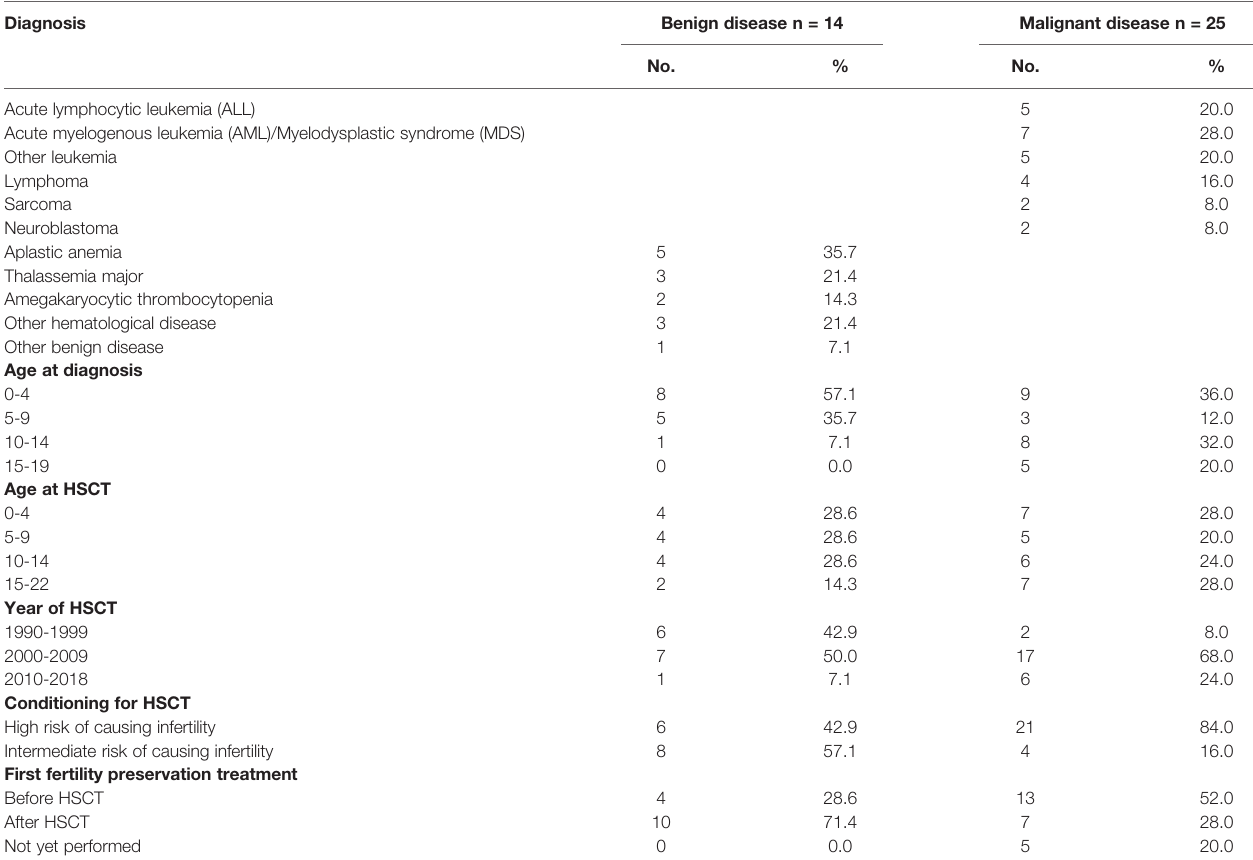
TABLE 1 | Description of cohort.